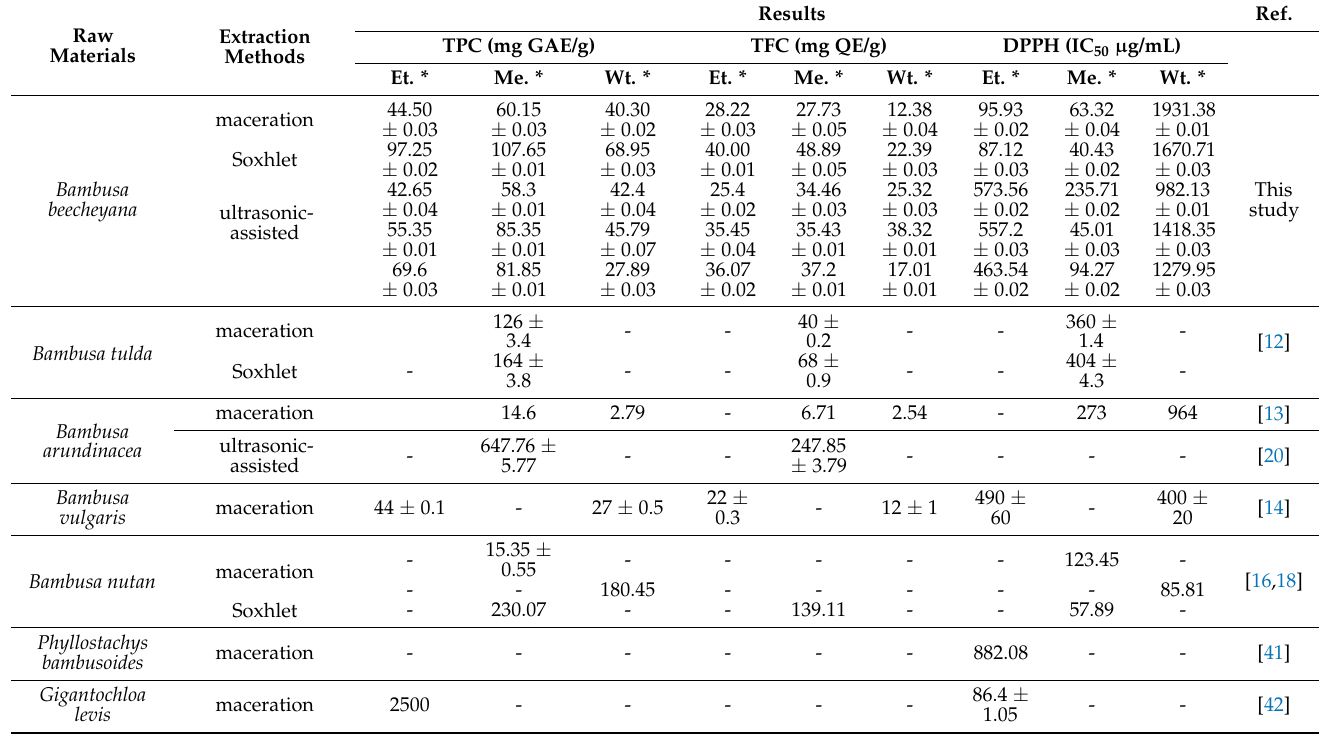
Table 5. Comparison of TPC, TFC, and DPPH scavenging activity of Bambusa beecheyana and various species of